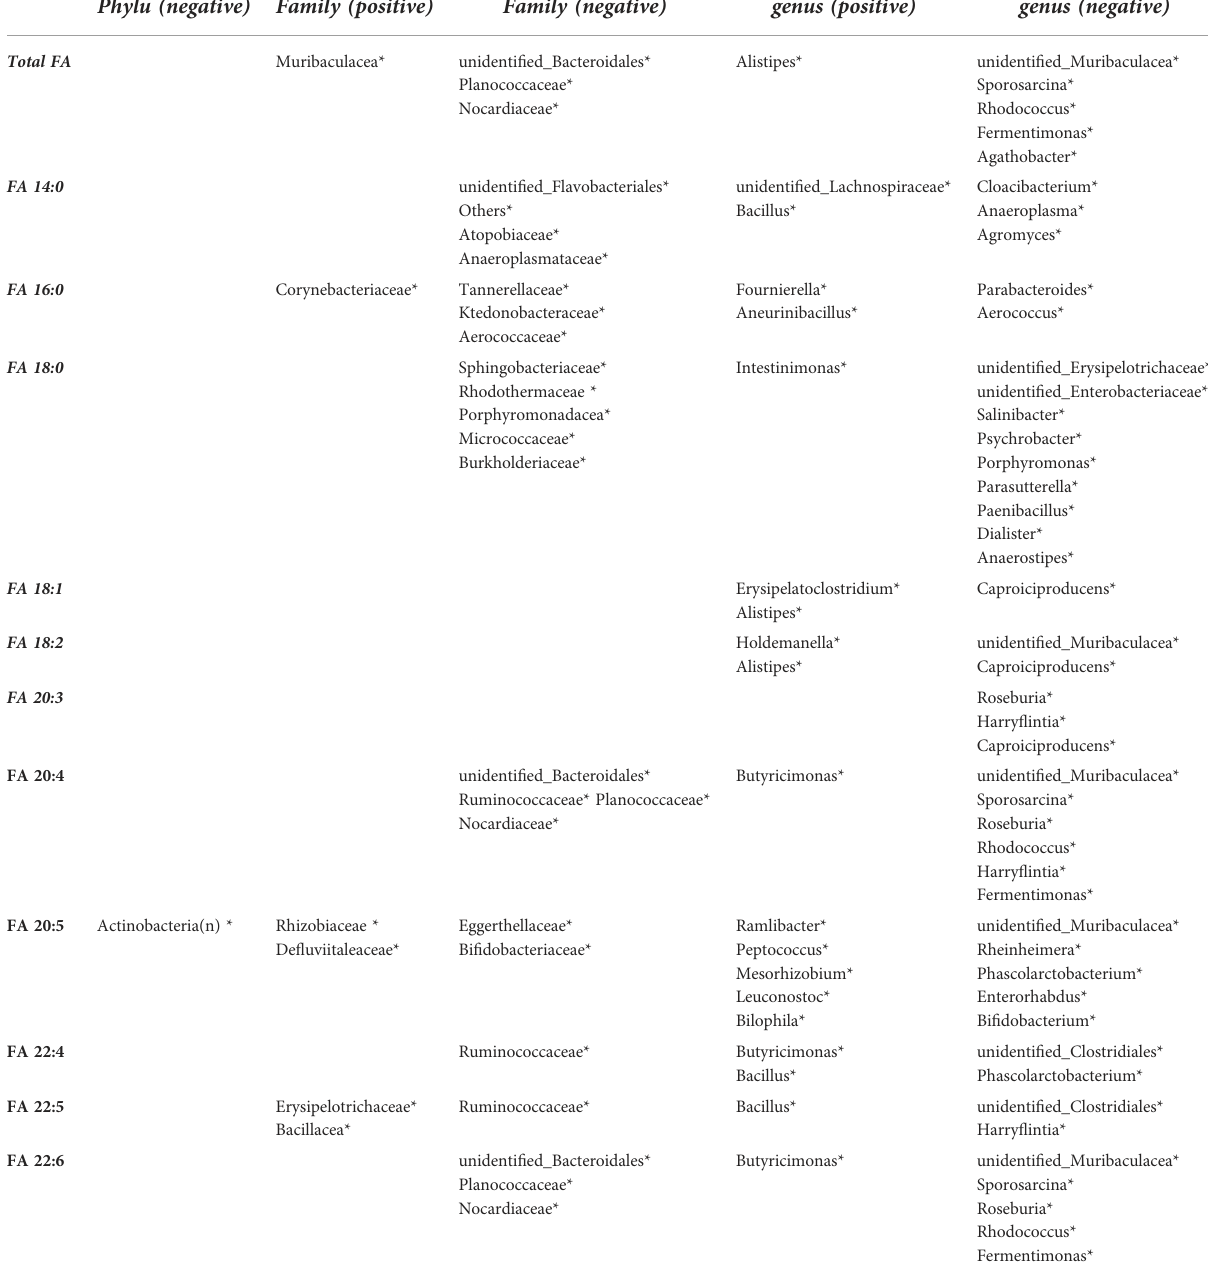
TABLE 1 Correlations between different gut microbiota and key hepatic